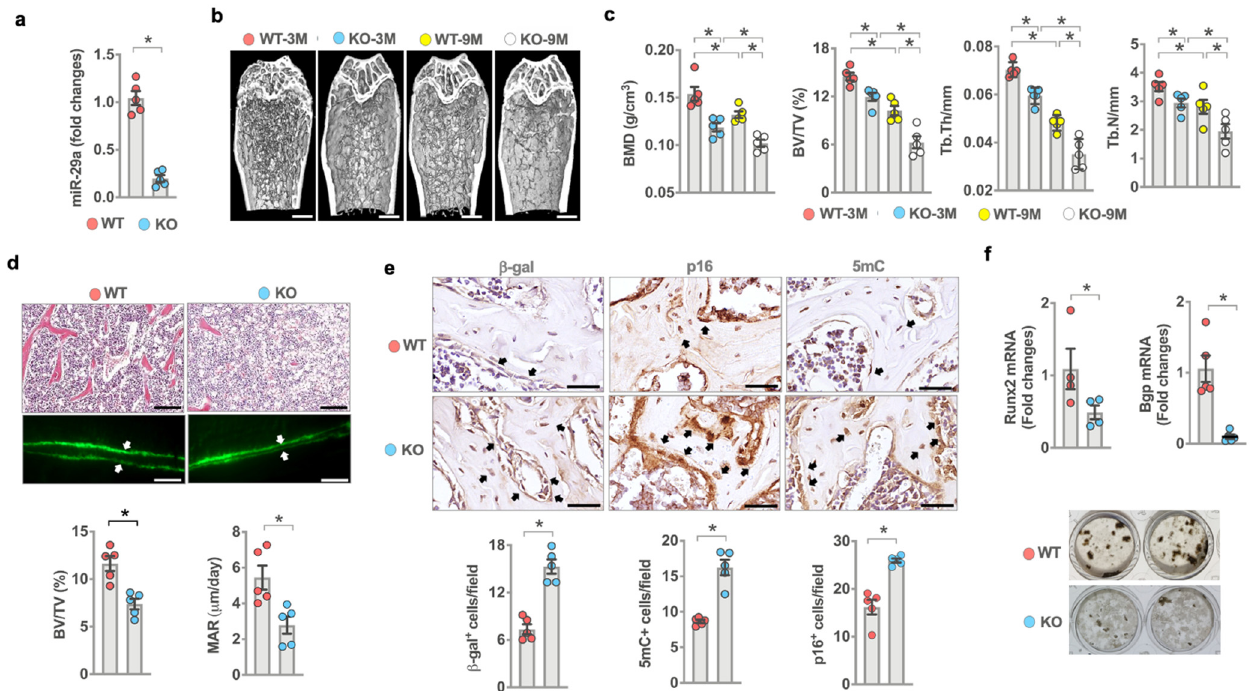
Figure 2. Analysis of miR-29a expression, osteoblast senescence, bone mass, and microstructure in miR-29a knockout mice. Low miR-29a expression in the bone tissue of 3-month-old miR-29aKO mice ( a ). μ CT images showing sparse trabecular microstructure ( b ) (scale bar, 50 μ m) and decreased BMD, BV/TV, Tb.Th, and Tb.N ( c ) in young and old miR-29aKO bone tissue. Significant differences of investigations (mean ± standard error, n = 5 mice) were analyzed using an ANOVA test and Bonferroni post hoc test. Three-month-old miR-29aKO bone tissue showed trabecular bone loss, marrow adiposis (scale bar, 20 μ m), weak calcein labeling (scale bar, 40 μ m), and decreased BV/TV and MAR ( d ). Osteoblasts in miR-29aKO bone tissue showed strong β -gal, p16, and 5mC immunostaining ( e ) (scale bar, 10 μ m). miR-29a knockout reduced osteogenic gene expression and von-Kossa-stained mineralization matrix deposition of bone-marrow stromal cells ( f ). Significant differences (asterisks *) of investigations (mean ± standard error, n = 5–6 mice) were analyzed using the Wilcoxon test.